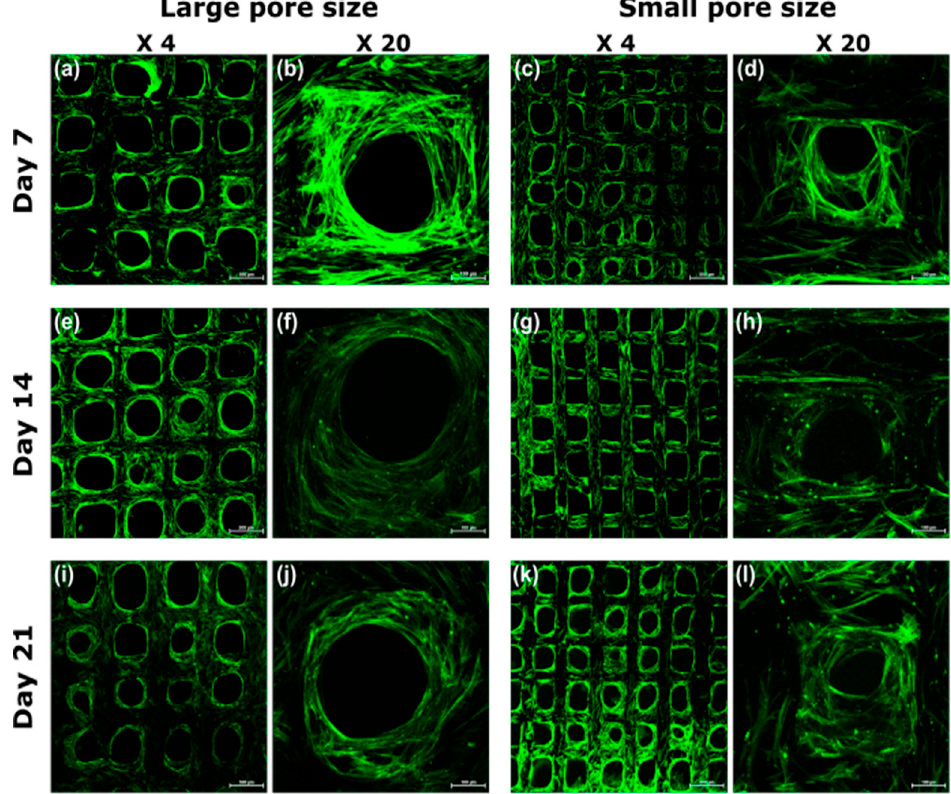
Figure 5. ( a – l ) Confocal images of hMSCs morphology on the scaffolds with different pore sizes cultured in the osteogenetic medium for 7, 14, and 21 days. Each sample was presented in low ( × 4) and high ( × 20) magnification. The scale bars in the images of × 4 columns are 500 µ m, and the scale bars in the images of × 20 columns are 100 µ m.